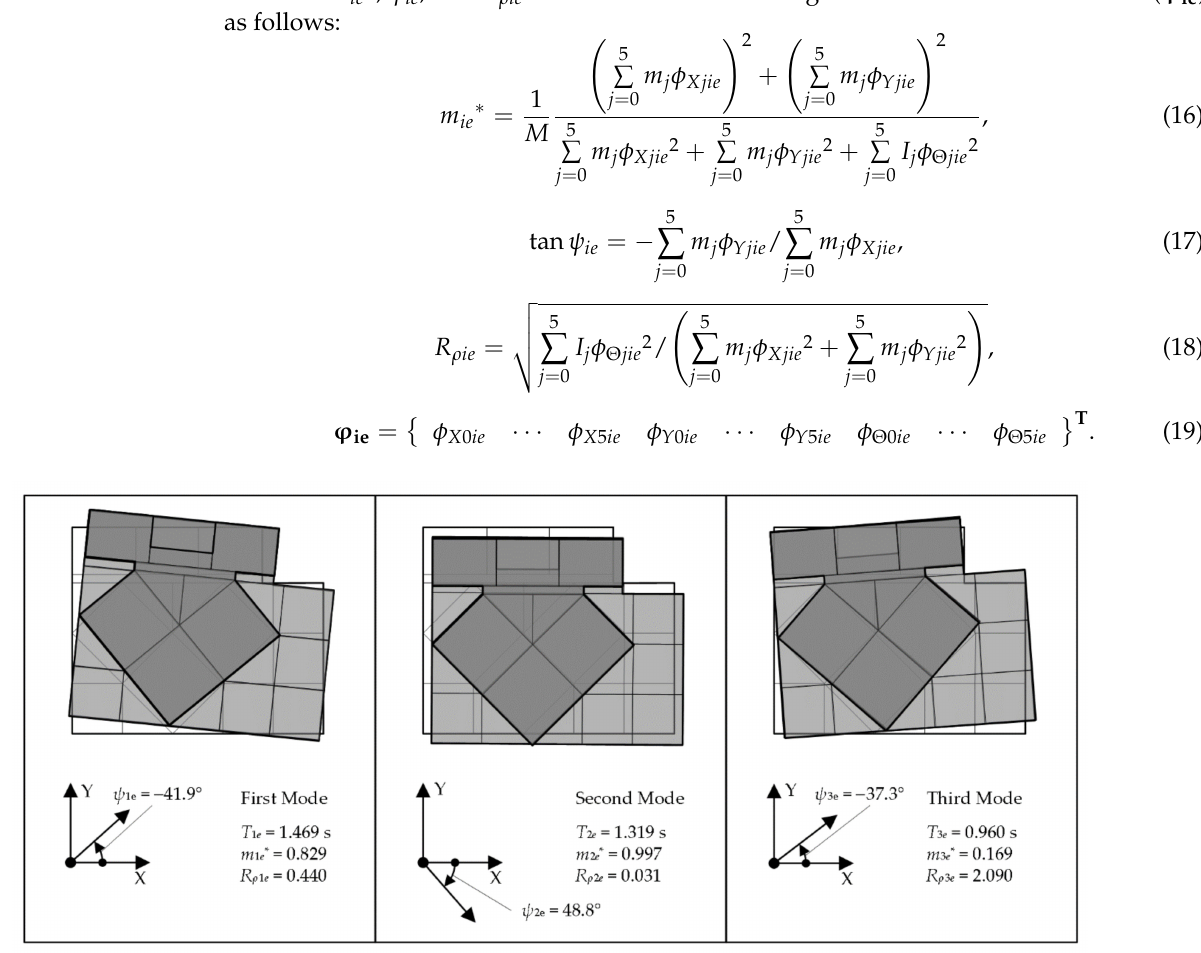
Figure 11. Shape of the first three natural modes of Model-Tf34 in the elastic range.